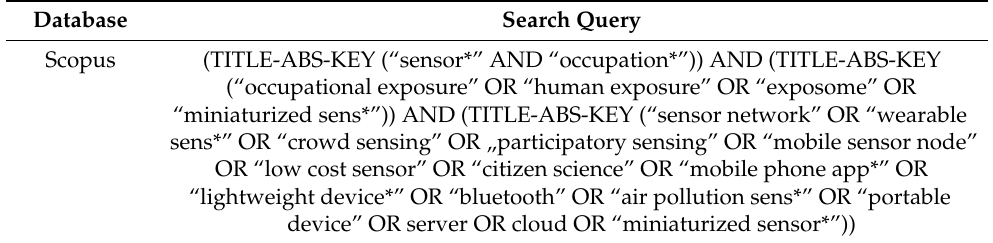
Table 1. Query used in the Scopus